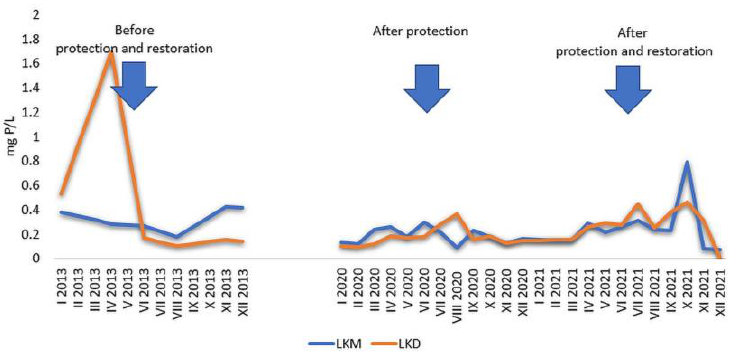
Figure 8. Changes in the content of organic phosphorus (P org .) in the surface water layer of Klasztorne lakes in selected research years.